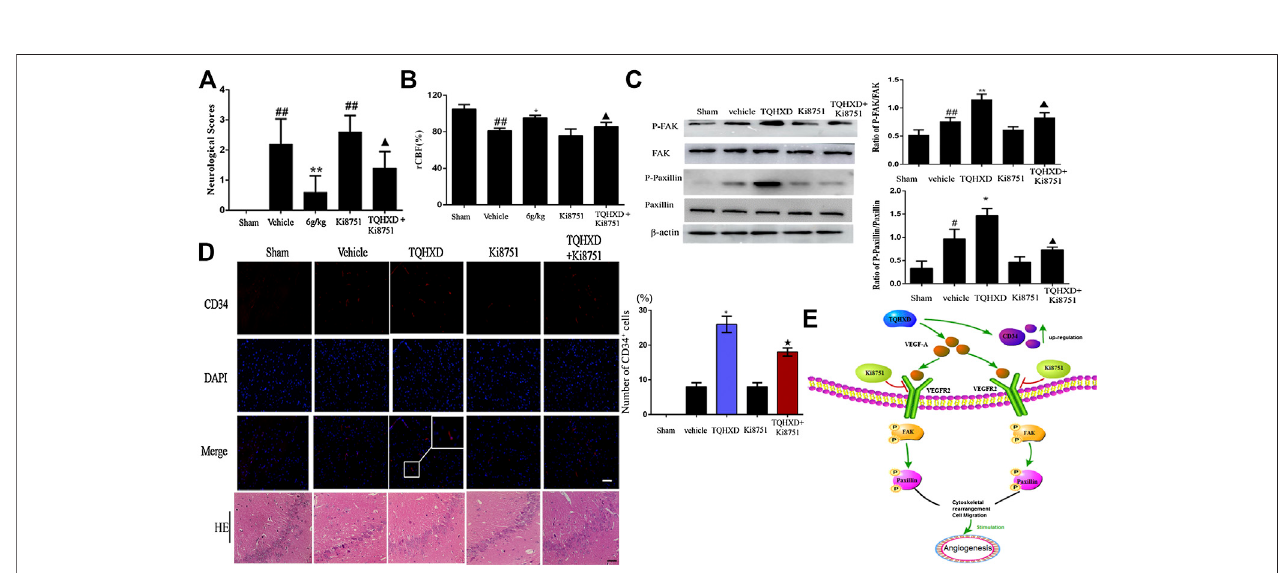
FIGURE 7 | TQHXD enhanced I/R-induced angiogenesis via activation of VEGF-A/VEGFR2-FAK-Paxillin signaling. (A) Neurological scores measured by Longa ’ s method( n (cid:1) 5). (B) ThechangesofrCBFforallgroupsat7 daysafterreperfusion, n (cid:1) 6. (C) RepresentativeWesternblotband (top) andquantitativeanalysis (bottom) of the expressions of FAK, p-FAK, Paxillin, and p-Paxillin ( n (cid:1) 3). β -Actin was used as an internal reference. (D) Left, serial sections of the brain were subjected to hematoxylin and eosin (HE) staining, immuno fl uorescence for angiogenesis markers (CD34, red), and DNA was stained by 4 ′ 6-diamidino-2-phenylindole (DAPI; blue). Whitebox implieszoom-in fl uorescence.Right,thehistogramsindicatethepercentagesofCD34-positivecells.Scalebar (cid:1) 50 μ m( × 200magni fi cation). Whitebox implies zoom-in fl uorescence. (E) The model illustrates the molecular mechanism of TQHXD on angiogenesis in MCAO injury rats. Data were expressed as mean ± SD. ## p < 0.01 vs. sham group; * p < 0.05, ** p < 0.01 vs. vehicle group; ▲ , + p < 0.05 vs. TQHXD (6 g/kg) group.